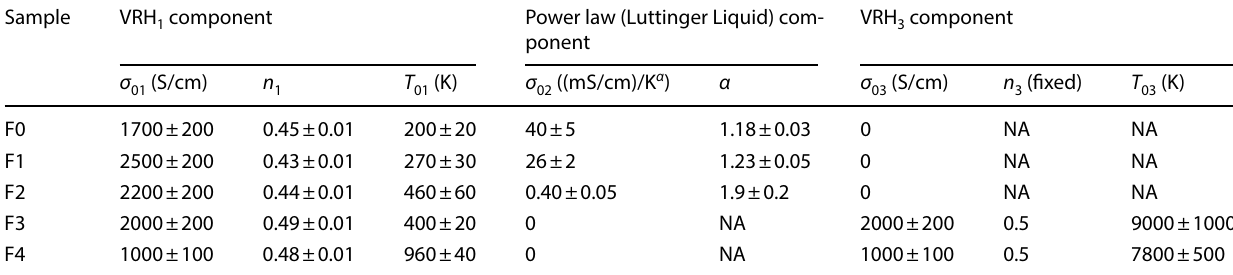
Table 1 Fitting parameters obtained from the fits using Eqs. 8, 9, 10, and 11 Sample VRH 1